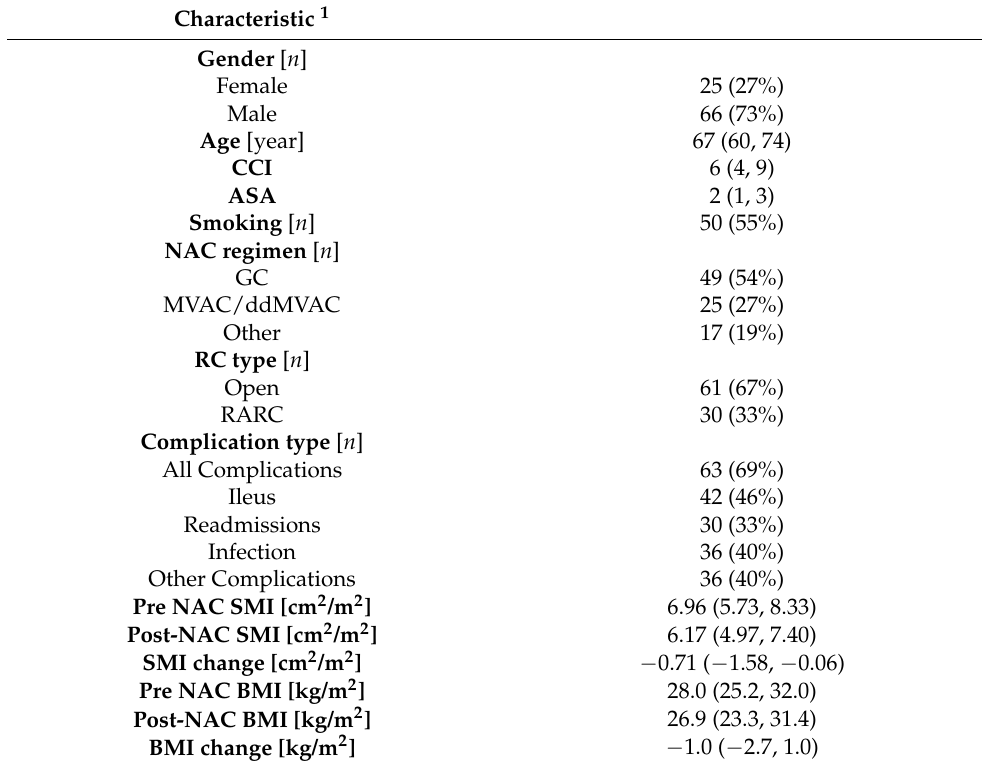
Table 1. Descriptive statistics of study